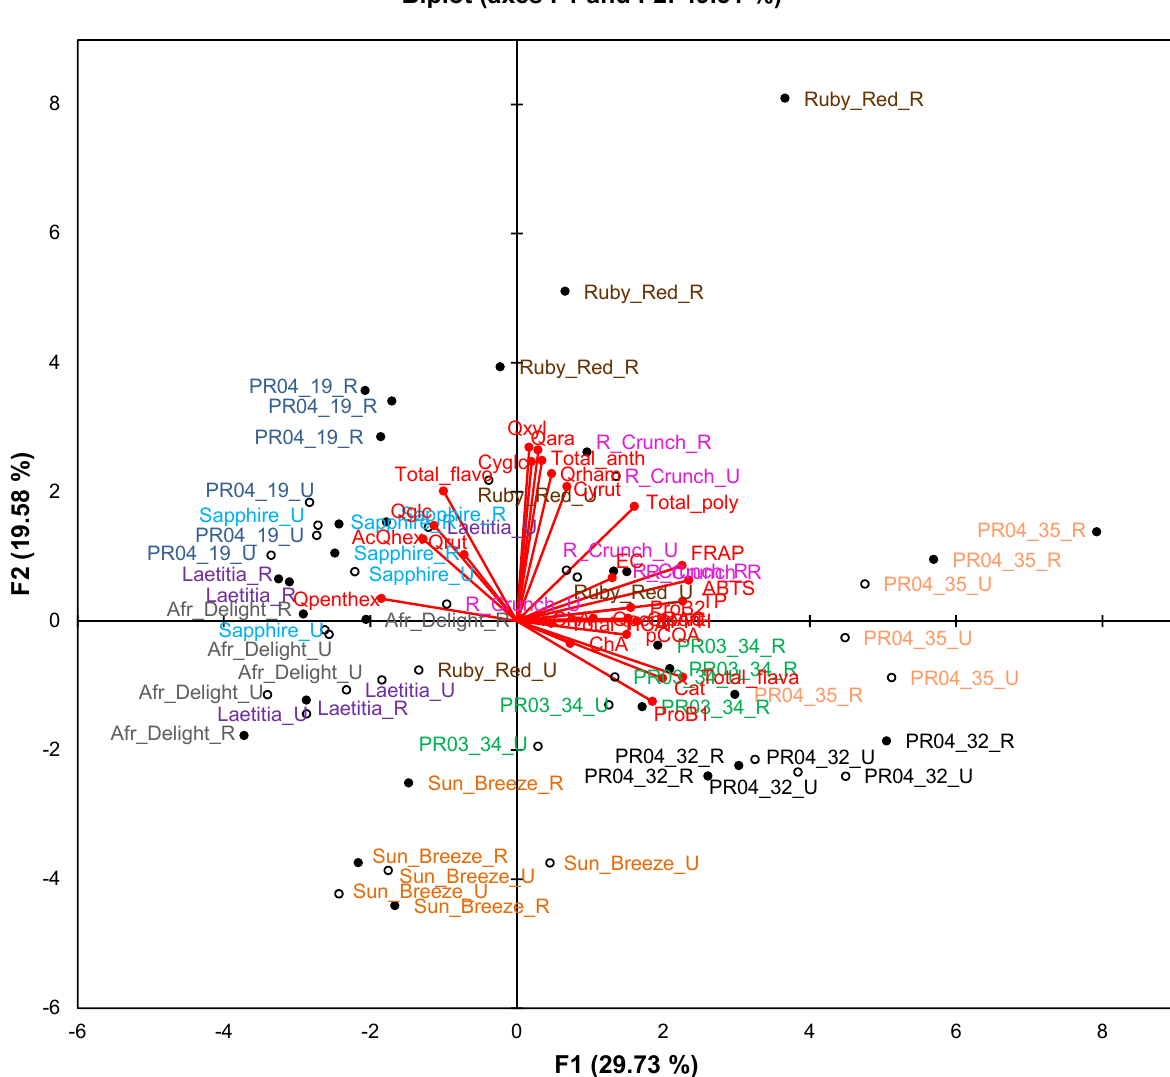
Figure 2. Principal component biplot of phenolic composition and total antioxidant capacity of unripe and ripe fruits from South African plum ( Prunus salicina Lindl.) cultivars and selections of the second harvest season. Biplot (axes F1 and F2: 49.31